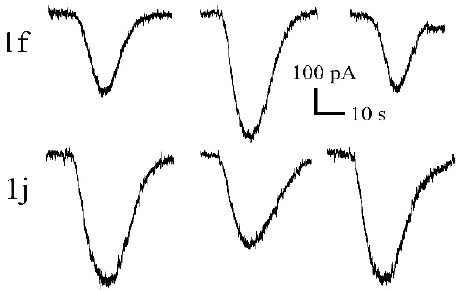
Figure 2. Kainate ‐ induced currents at 10 − 9 M concentration for compounds 1f and 1j (left—control, center—after application of the compound, right—after wash ‐ out).